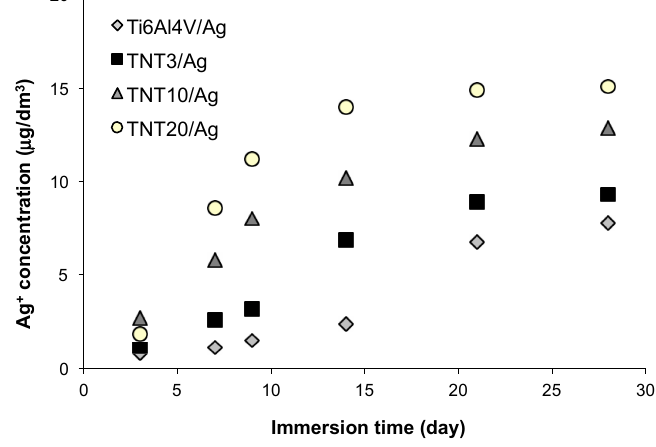
Figure 9. The cumulative silver release profile obtained on the basis of ICPMS data.